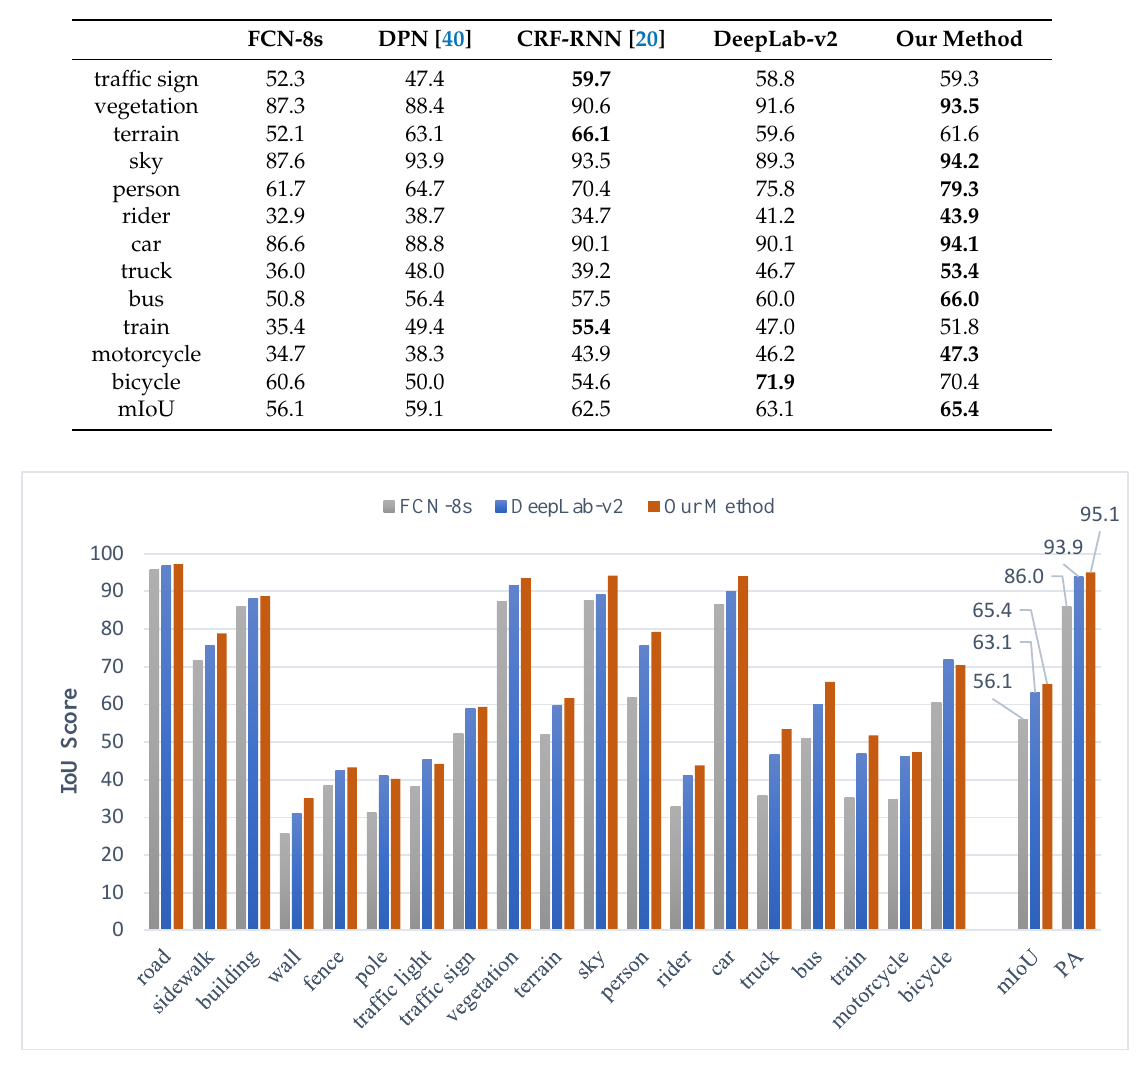
Figure 14. IoU, mIoU, and PA scores on the Cityscapes dataset.